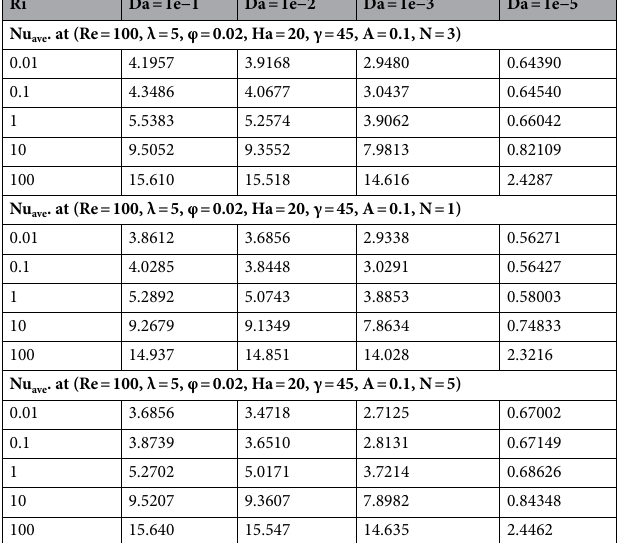
Table 5. Effect of Ri, Da and N on the average Nusselt number for Case 1.